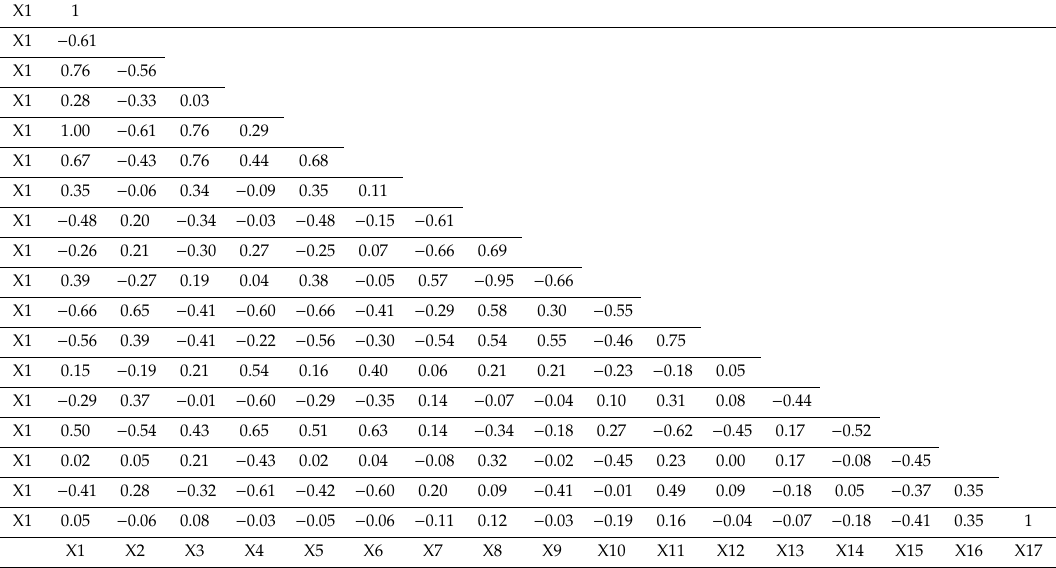
Table 2. Pearson’s table featuring correlations between selected